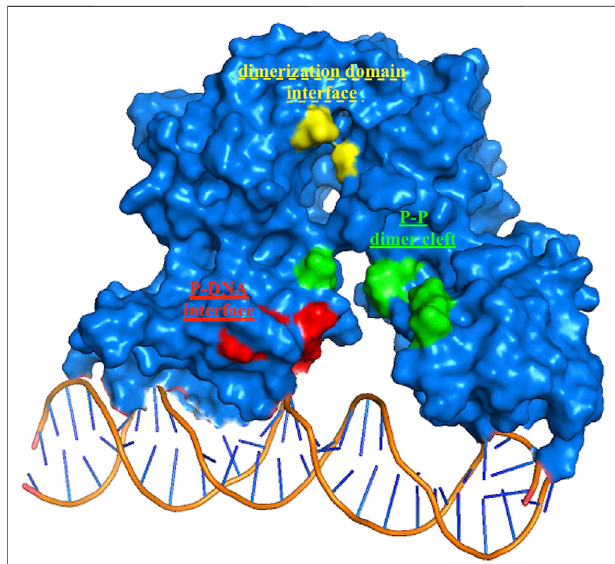
FIGURE 3 | HP1043 binding sites. Residues belonging to the three principal binding sites, in green residues at the dimer cleft (P – P and single underlinedin Table2 ),inyellowresiduesatthedimerizationdomainsinterface (dotted-underlined in Table 2 ), and in red residues at the A chain – DNA interface (double-underlined in Table 2